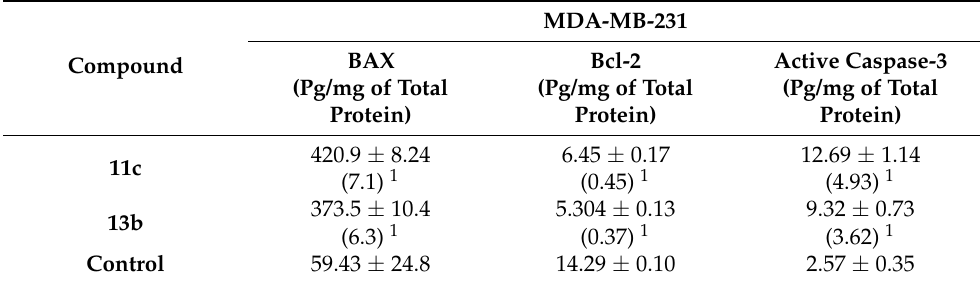
Table 4. Effect of QBS 11c and 13b on the expression levels of Bax, Bcl-2 and active Caspase-3 in breast cancer MDA-MB-231 cells.